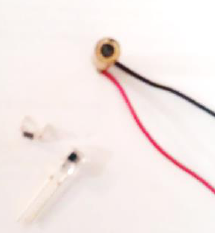
Figure 8. Laser sender and receiver